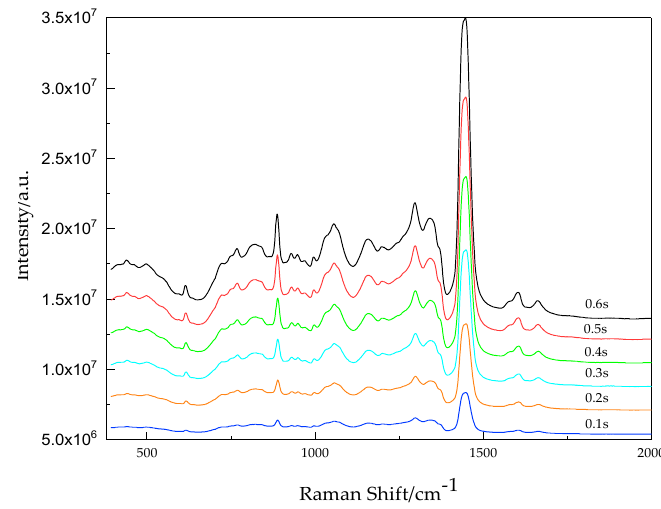
Figure 6. Raman spectra of 40 mg/mL acetic acid-transformer oil at different exposure time.